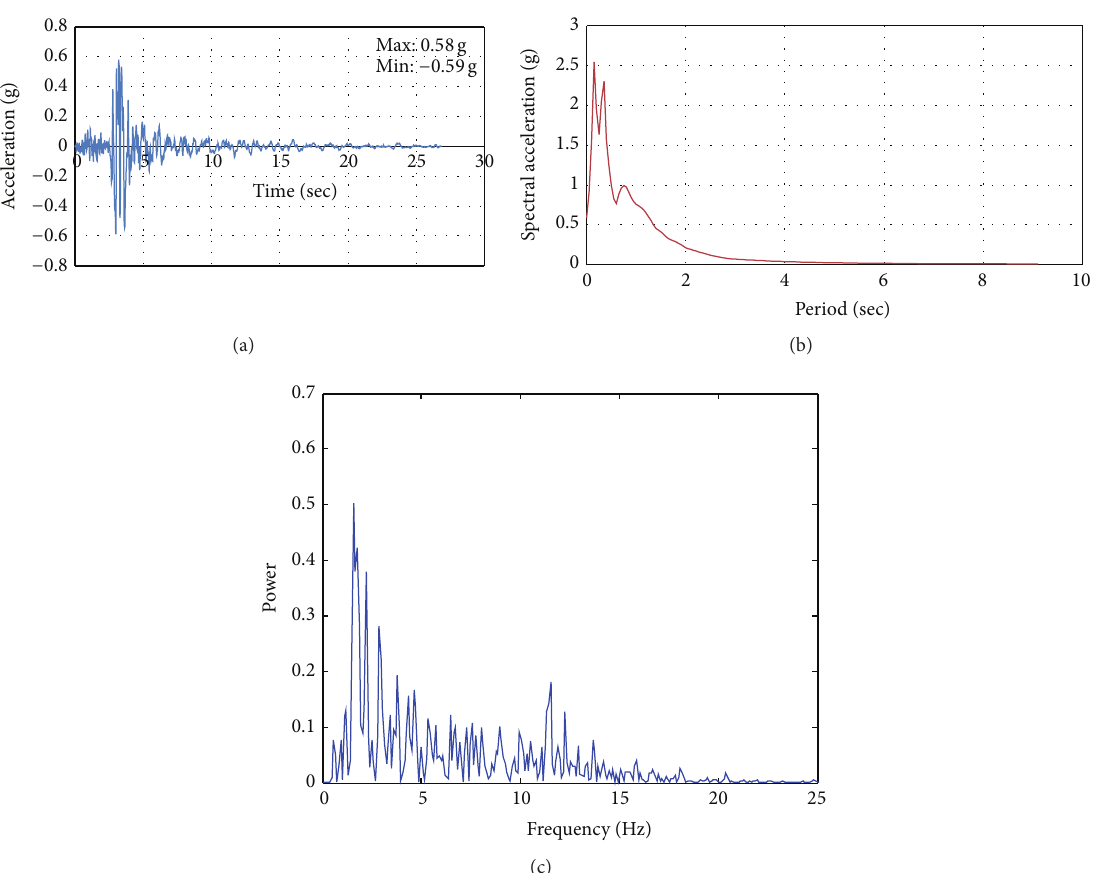
Figure 2: (a) Seismic excitation signal, (b) spectral accelerations, and (c) power spectral density of selected ground motion.